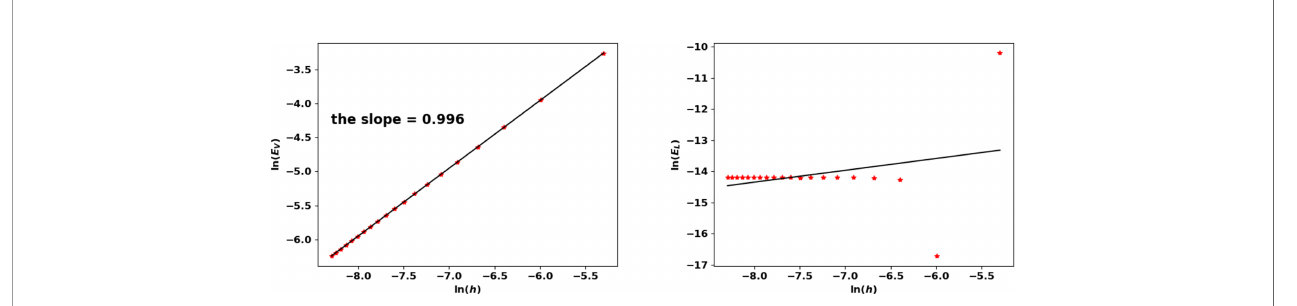
FIGURE 10 | Binary division kernel: convergence rates of ( l ( K ) , N ( K ) ) with respect to h .